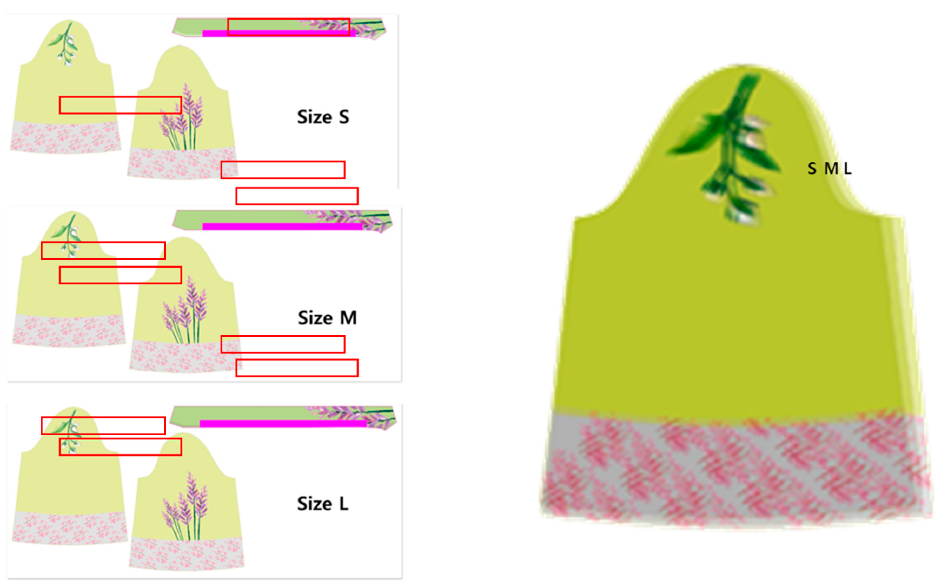
Figure 26. After customer design mapping.